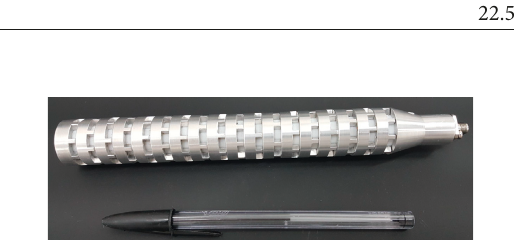
Figure 6: Novel SWAA prototype.